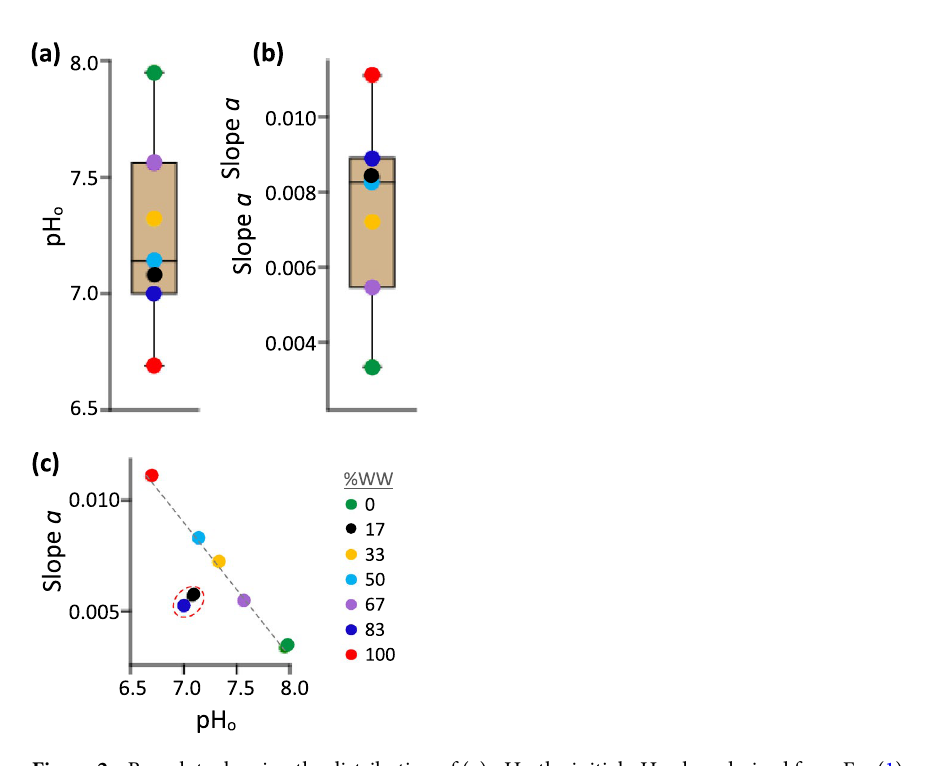
Figure 2. Box plots showing the distribution of ( a ) pH 0 , the initial pH values derived from Eq. (1), and ( b ) the accompanying slope a . ( c ) The linear relationship of a to pH 0 , expressed as a = − (0.0061* pH 0 ) + 0.052. Expected a values for the 67 and 83% WW were used in ( b ); the observed values for 67 and 83% WW are encircled in ( c ) to highlight this